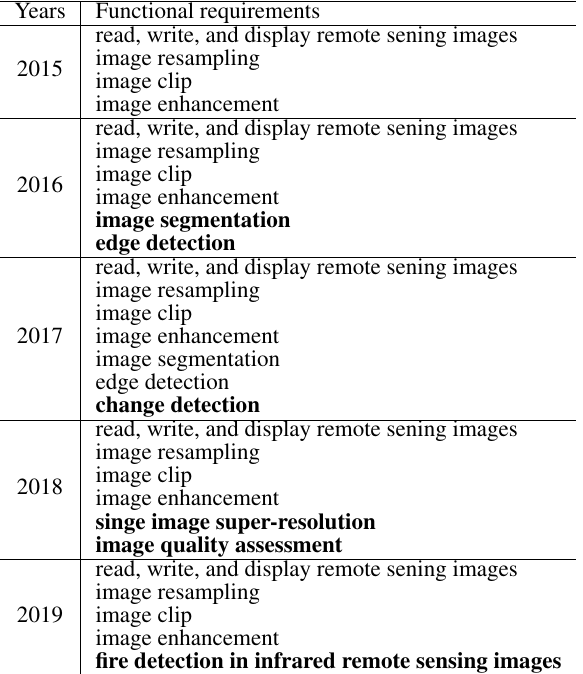
Table 1. Required functions of the remote sensing image processing software. Bold text indicates updated